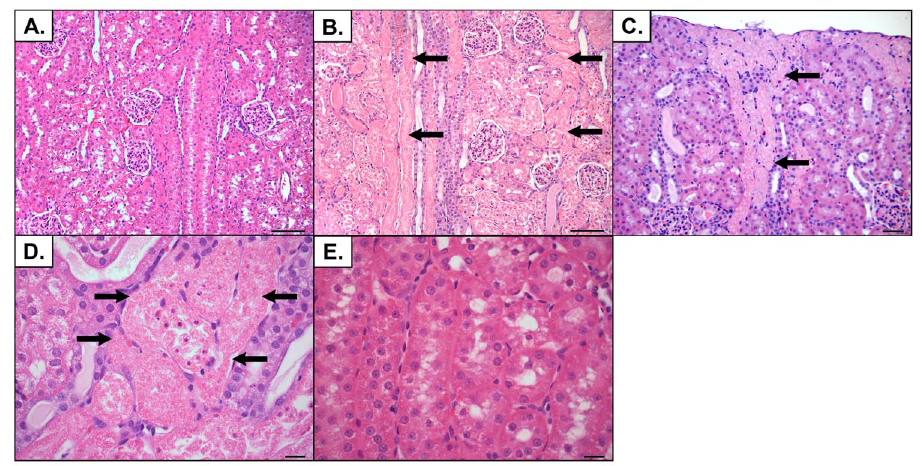
Figure 4. Representative histological lesions in kidneys from rabbits subjected to CIAKI. Renal cortex from rabbits treated with (A) 2.5 g I/kg CM, (B) 10.0 g I/kg CM, or (C) 5.0 g I/kg CM and sildenafil citrate (6.0 mg/kg, q8 h). In a rabbit treated with 2.5 g I/kg there were no histological alterations in the cortex. (A, summary pathology score 5 0) In a rabbit treated with 10.0 g I/kg there was severe tubular necrosis (arrows) affecting . 50% of the cortical tubules. (B, summary pathology score 5 7). In a rabbit treated with 5.0 g I/kg CM and sildenafil citrate there was tubular necrosis affecting a much smaller percentage of cortical tubules (C, summary pathology score 5 3). Higher magnification of tubular necrosis from a rabbit in the 10.0 g I/kg group shows details of tubular necrosis, (arrows) evidenced by loss of cellular detail in the tubules, nuclear loss or condensation, and sloughing of necrotic cell debris into the tubule lumen. (D). A similar area in a rabbit treated with 2.5 g I/kg CM shows no alterations in the tubules (E). Hematoxylin and eosin stain. Original magnifications for A, B, C 5 6 200; bars 5 100 m m; for D, E 5 6 600, bar 5 20 m m.